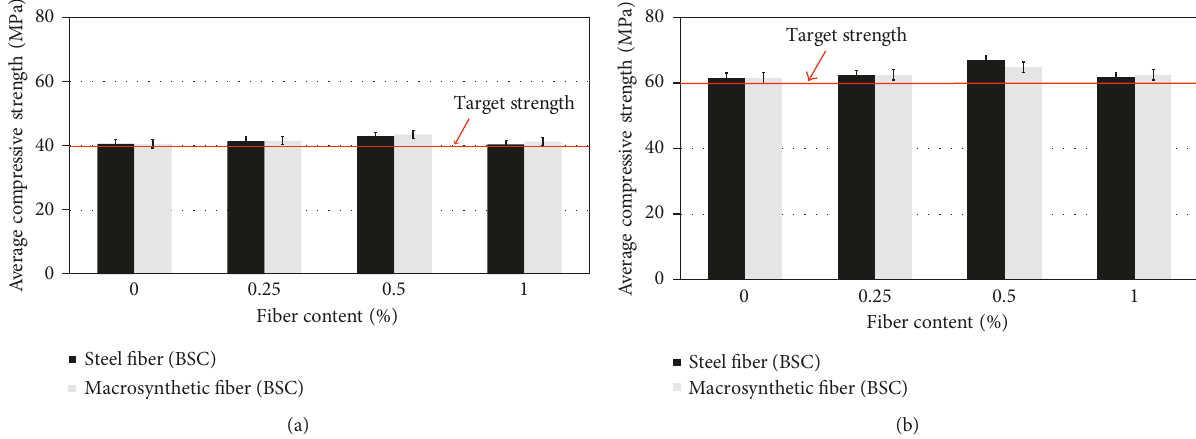
Figure 9: Compressive strength of BSC segment with reinforcing fiber type. (a) Target strength 40MPa. (b) Target strength 60MPa.